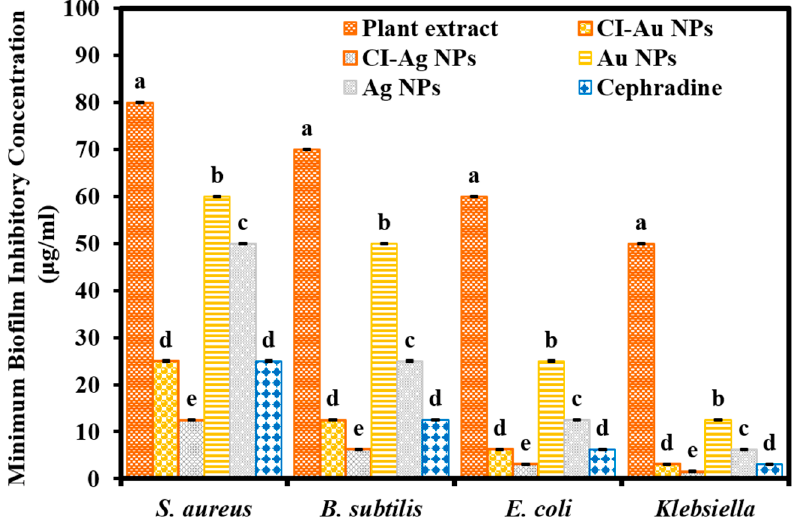
Figure 7. Biofilm inhibition activity of green synthesized CI-Au NPs, and CI-Ag NPs in terms of minimum biofilm inhibitory concentrations (MBICs) against different bacterial strains in comparison to C. inerme leaves extract, commercially purchased Au and Ag NPs, as well as Cephradine. (Note: Tukey based heterogenous lower-case letters represent significant statistical pairs) .